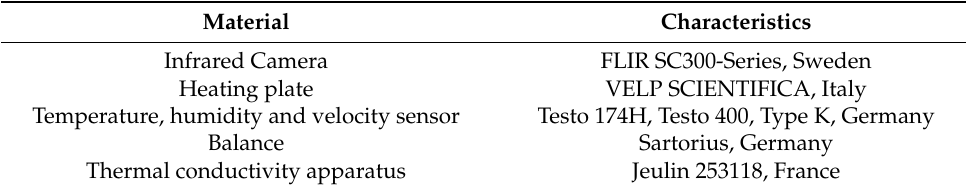
Table 3. Characteristics of the experimental materials.